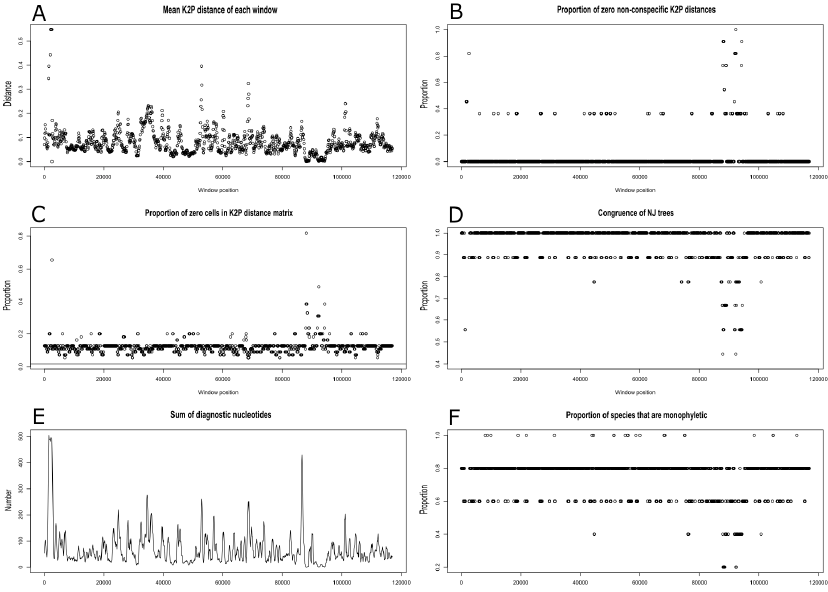
Figure 6. Results of several analyses across the plastome sequences of five Marchantiidae species with at least two sequenced specimens using the sliding window method. A —the plot of the mean Kimura 2-parameter distance matrix for each 500 bp-long window. B —the proportion of zero non-conspecific distances. C —the proportion of zero cells in the distance matrix. The unbroken horizontal line crossing the y-axis at 0 is the proportion of zero cells in the distance matrix created from the full dataset. D —the proportion of clades that are identical between the windows and the full dataset. E — the sum of diagnostic nucleotide positions for all species. F —the proportion of species that are monophyletic.